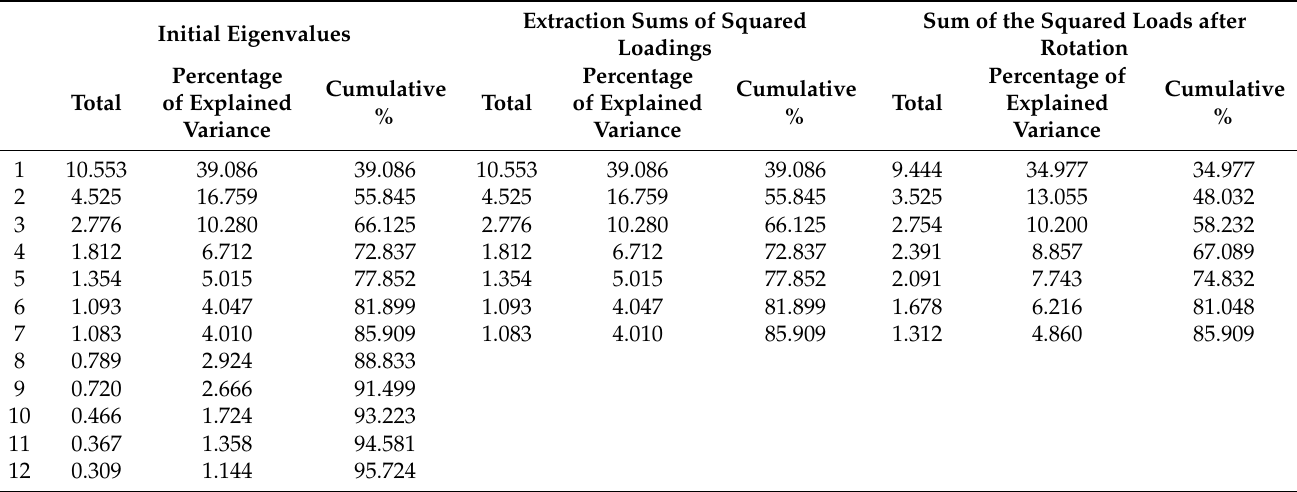
Table A3. Total variance explanation of common